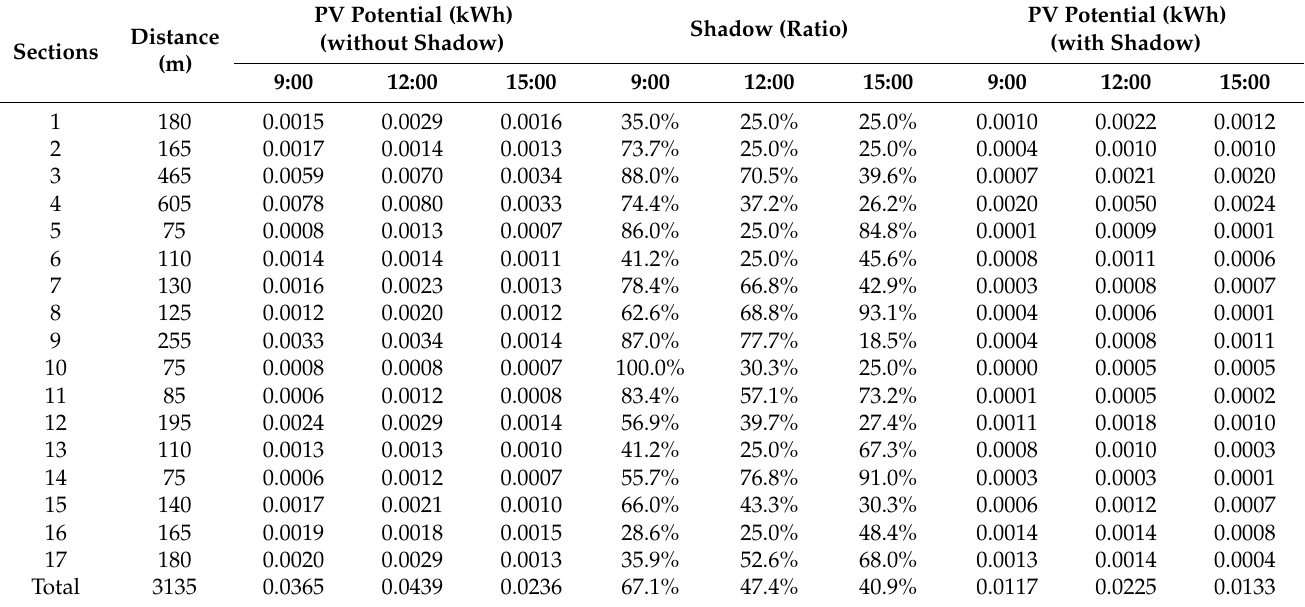
Table 3. Ratio of shaded area and PV potential with/without shadow effect in each section.